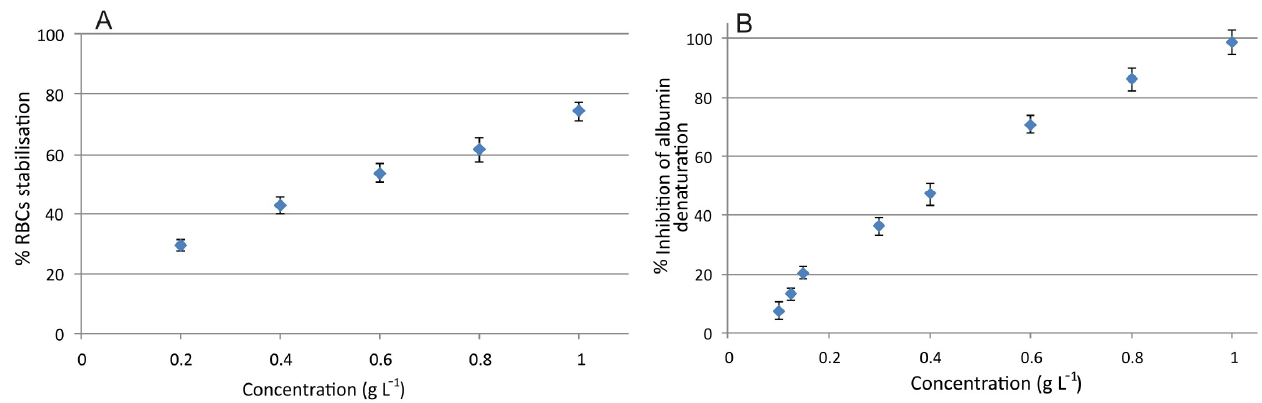
Figure 3. ( A ) Red blood cell membrane stabilization and ( B ) inhibition of albumin denaturation by Urtica dioica L.